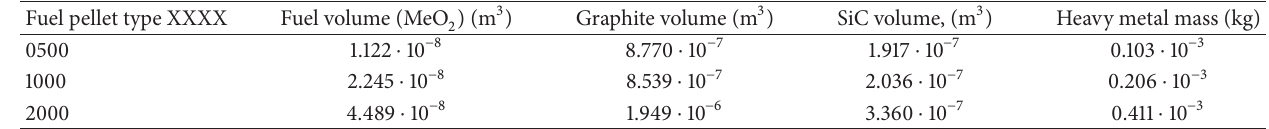
Table 1: Classification of FPs of